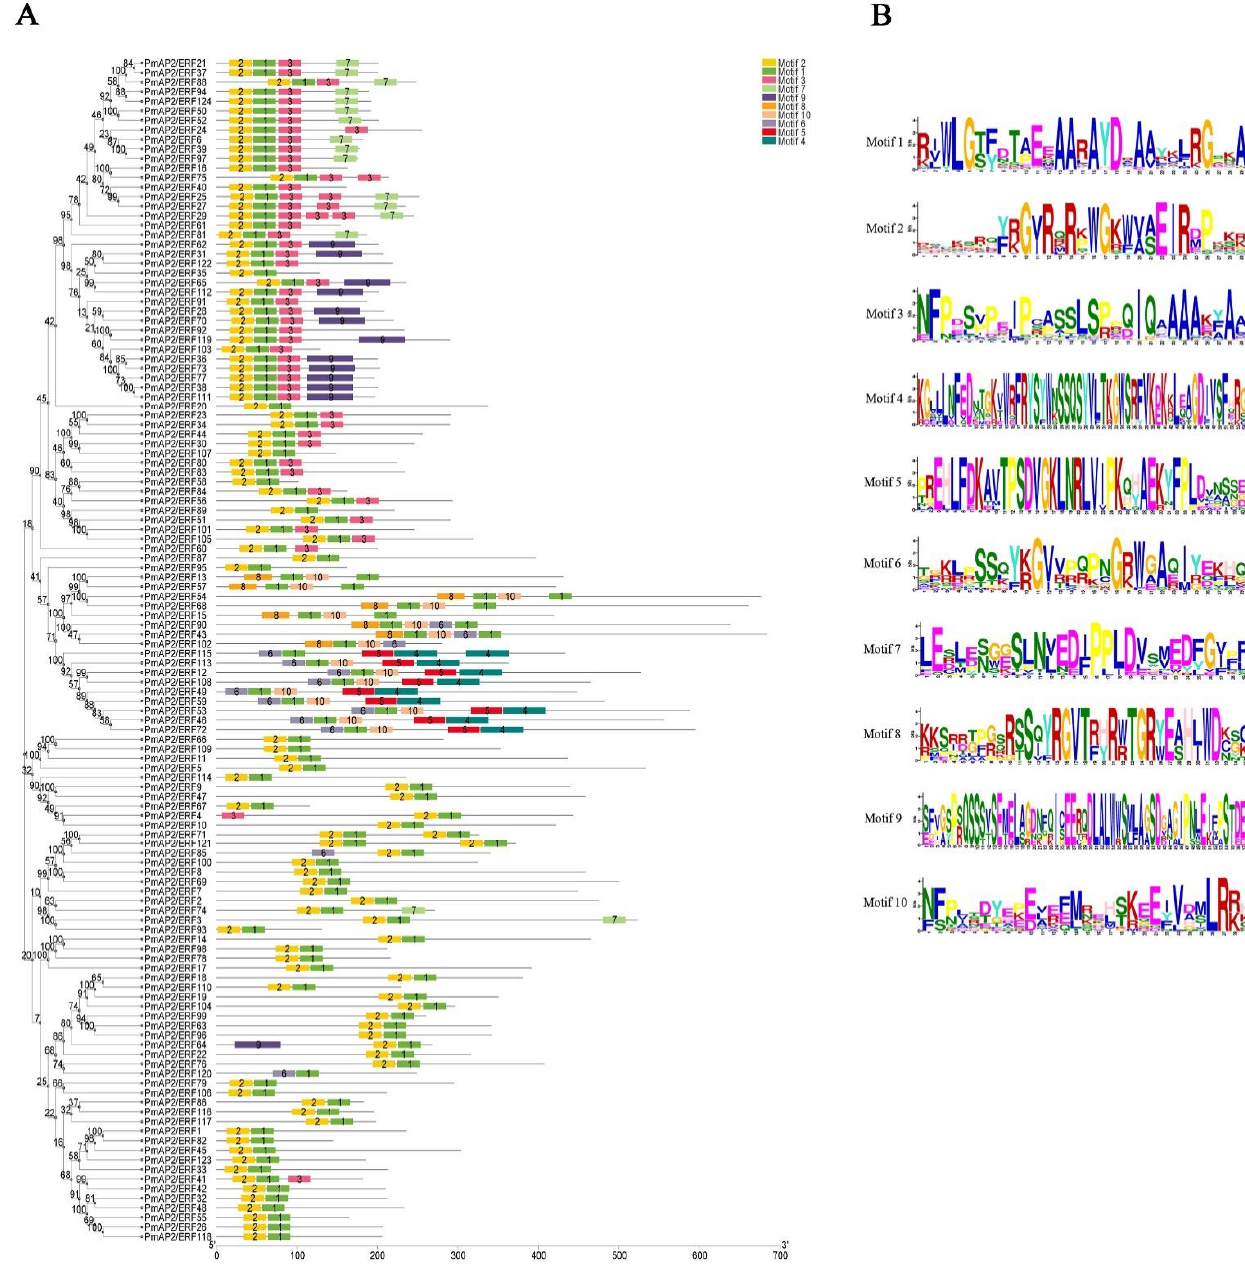
Figure 3. Conserved motif analysis of PmAP2/ERFs proteins of P. massoniana and multiple sequence alignment of AP2 structural domain proteins: ( A ): Distribution of conserved motifs of PmAP2/ERFs proteins of P. massoniana . A total of 10 conserved Motifs were obtained, indicated by different numbers and colors, and arranged in order. ( B ): Conserved motifs of PmAP2/ERFs proteins of P. massoniana . Corresponds to Motif in A.